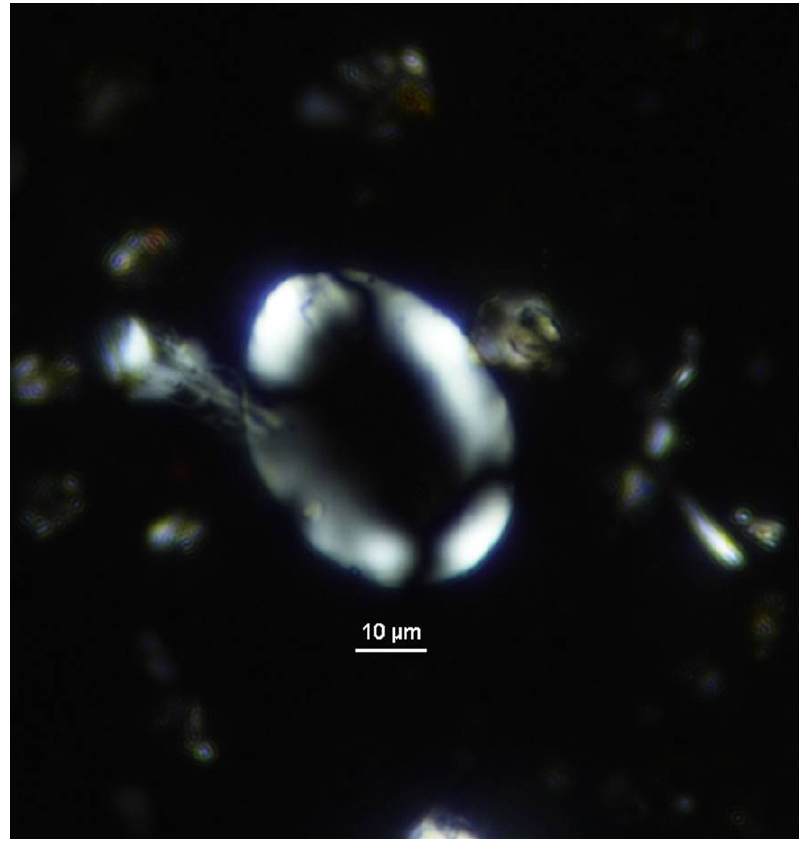
Figure 11. Recovered starch grain in transmitted light. Artefact 5, point sample 1, at